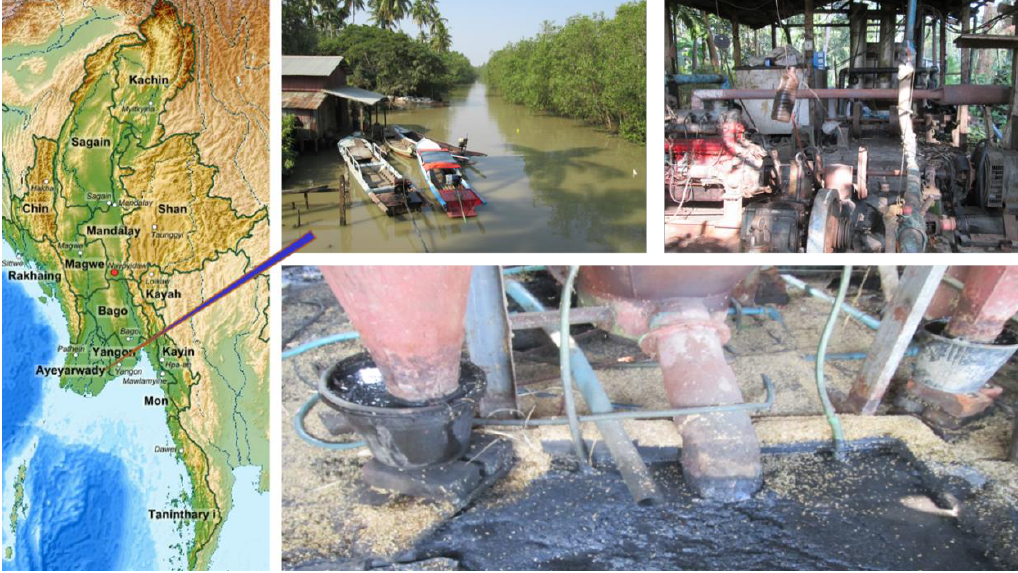
Figure 1. Case study of rice husk gasifiers in Kyawzan village, Ayeyarwady region.